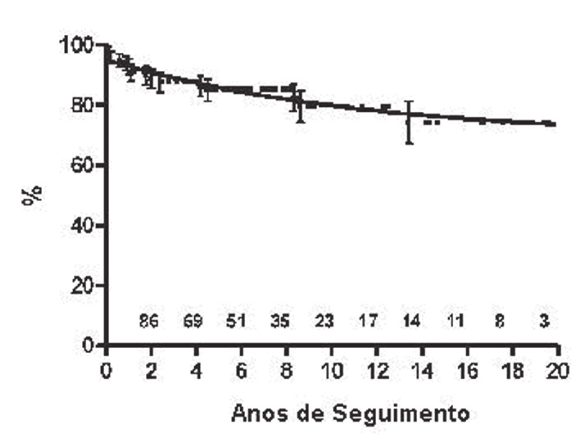
Fig. 1 - Estimativa da probabilidade de sobrevivência das crianças submetidas à estimulação cardíaca permanente pela via endocárdica transfemoral, pelo método de Kaplan-Meier. Números